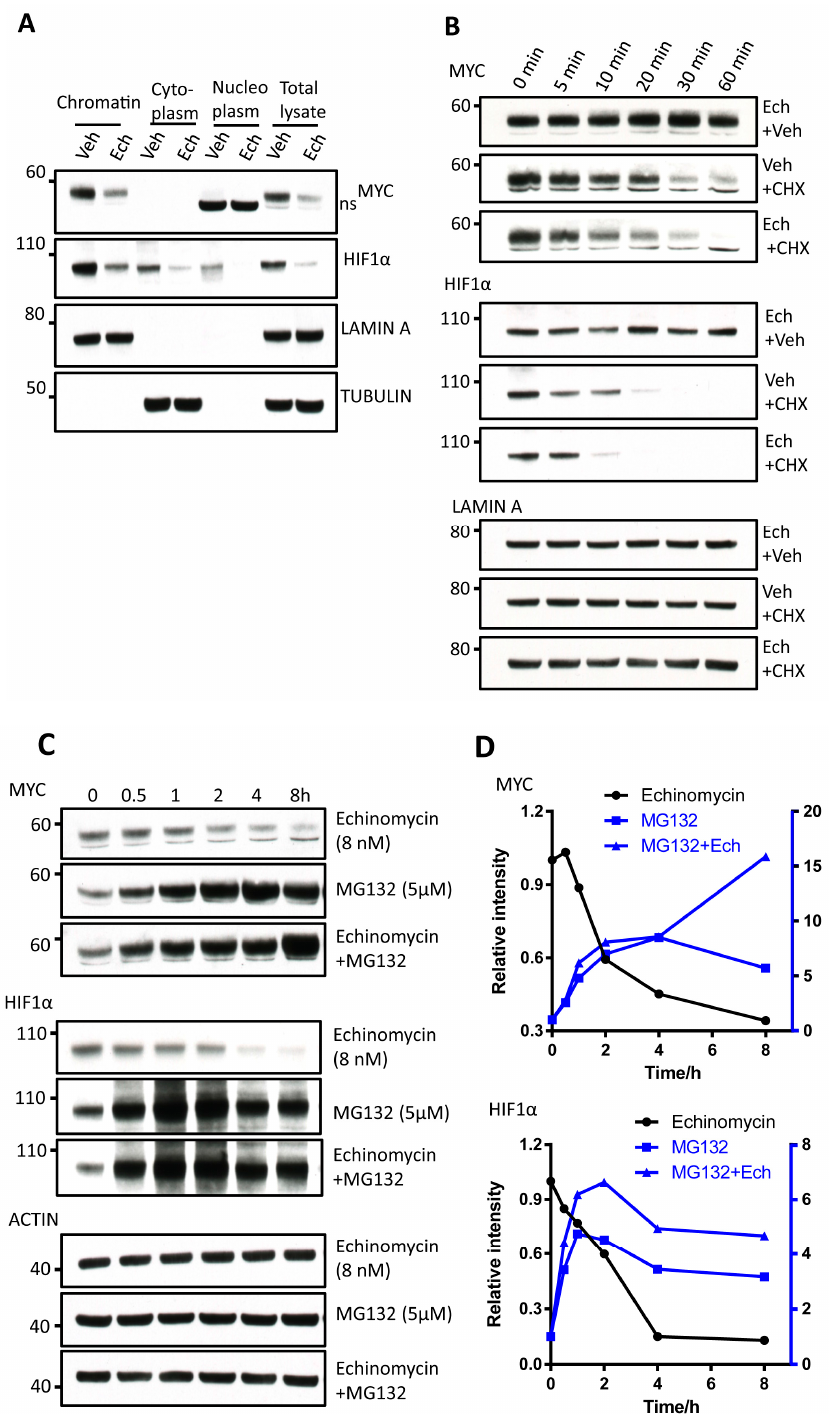
Figure 2. Induction of proteasomal degradation of MYC and HIF1 α by echinomycin. ( A ) MYC and HIF1 α in cytosol, nucleoplasm and chromatin in H1944 cells treated with 4 nM echinomycin (Ech) or vehicle (Veh) for 24 h were analyzed by western blot after fractionation. Experiments were repeated 3 times. ( B ) Chromatin-bound MYC and HIF1 α in H1944 cells treated with echinomycin (Ech, 8 nM), cycloheximide (CHX, 25 µ g/mL) or Ech + CHX for indicated time were checked by western blot. Experiments were repeated two times. ( C ) Quantification of MYC and HIF1 α in ( B ). ( D ) H1944 cells were treated with echinomycin (Ech, 8 nM), MG132 (5 µ M) or Ech + MG132 for indicated time, and MYC and HIF1 α proteins were analyzed by western blot. Experiments were repeated two times. Quantification of MYC and HIF1 α in ( D